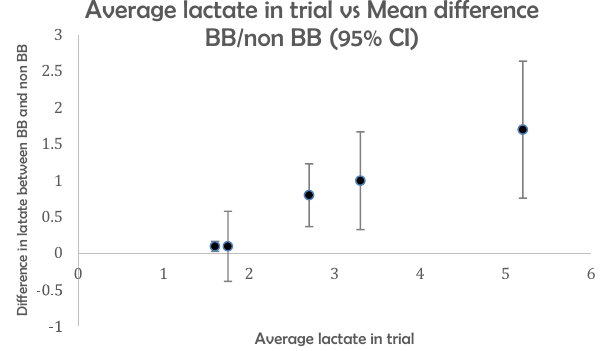
Figure 2. Average lactate in individual trials vs. difference in mean lactate for those prescribed and not previously prescribed beta